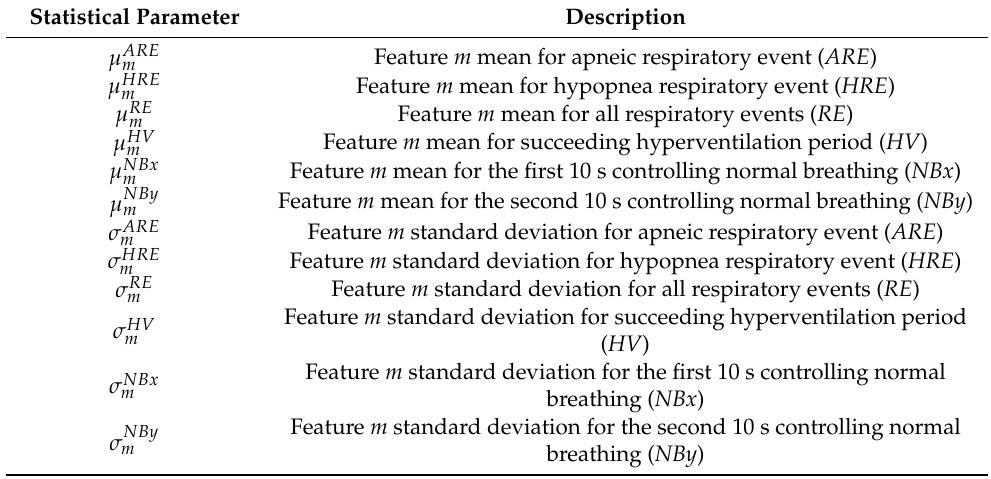
Table 4. List of statistical